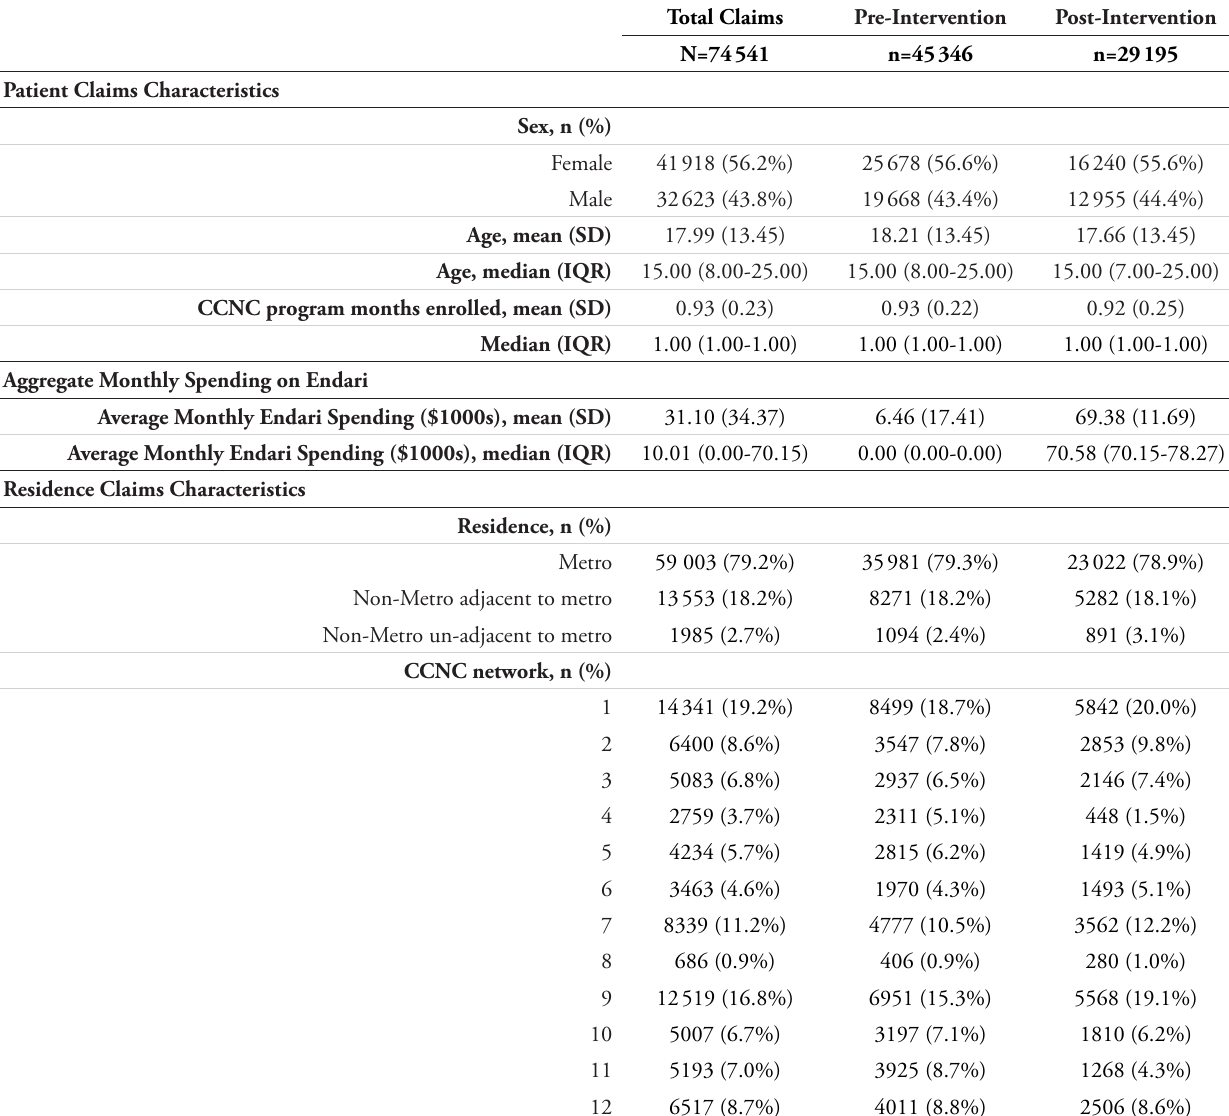
Table 1. Summary Statistics for Enrollee Characteristics Pre- and Post-Intervention